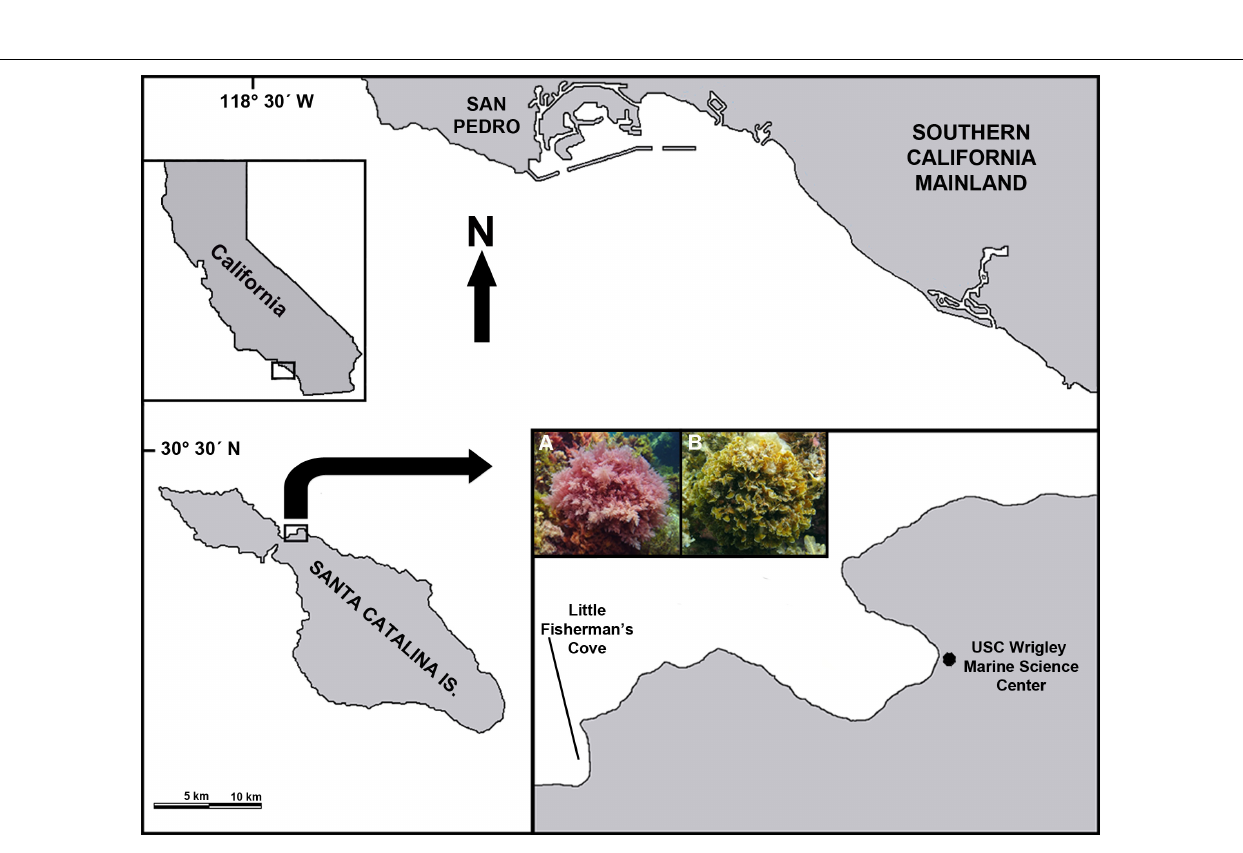
FIGURE 2 | Sampling sites. Map showing the location of Santa Catalina Island relative to the Southern California mainland. Inset on right: the red alga Asparagopsis taxiformis (A) and the brown alga Zonaria farlowii (B) . Algae were collected (2–5 m depth) in Little Fisherman’s Cove, located ∼ 0.6 km from the USC Wrigley Marine Science